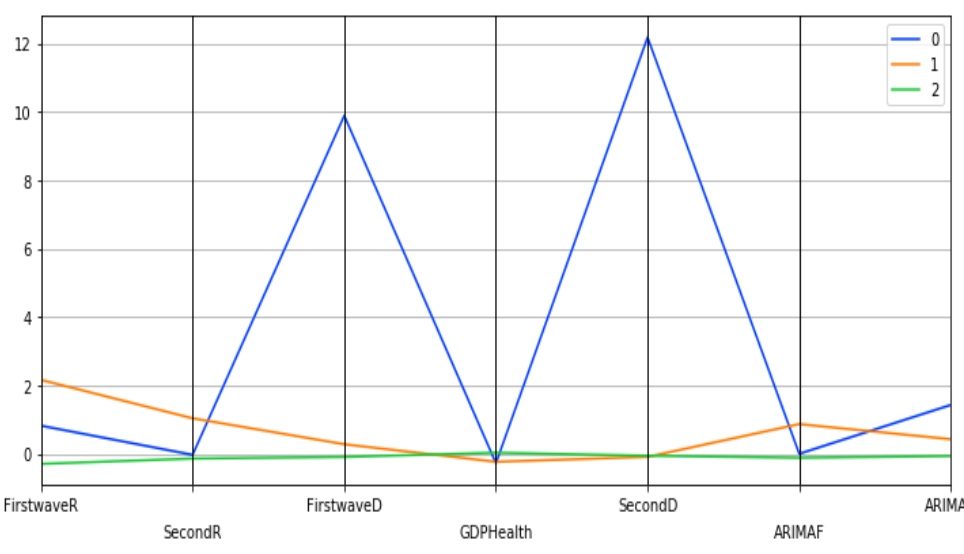
Figure 12. Parallel coordinates for cluster centroids.